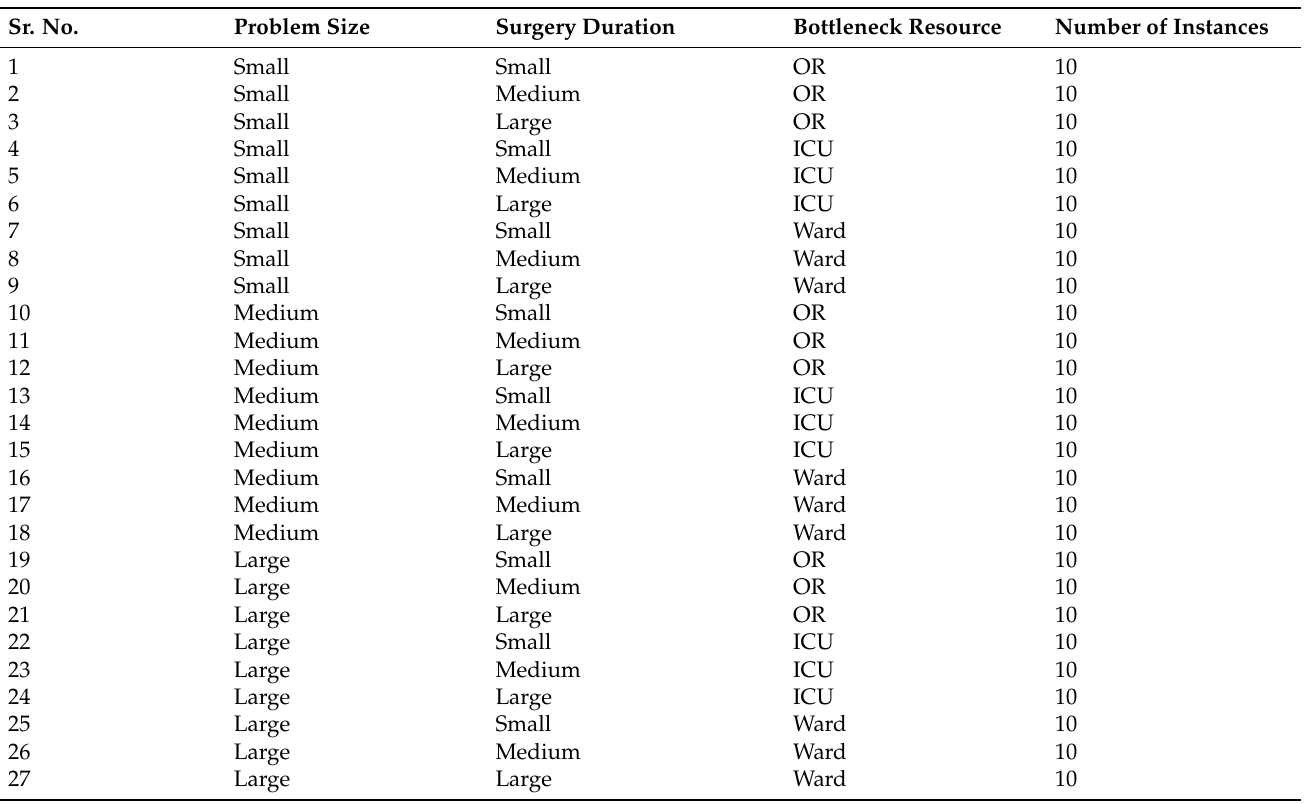
Table 2. Matrix of